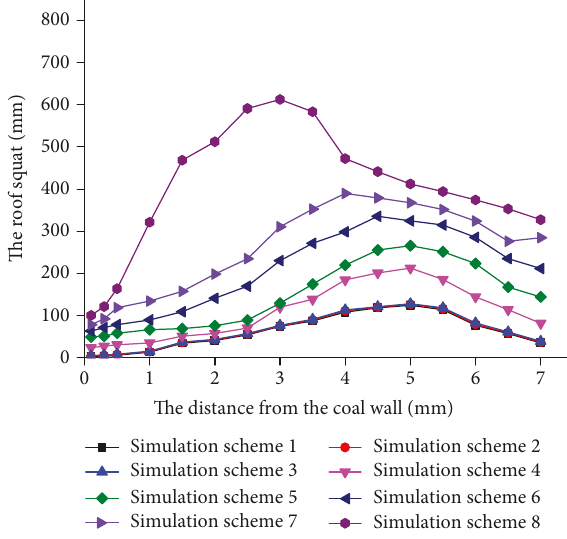
Figure 11: Roof squad versus cutting